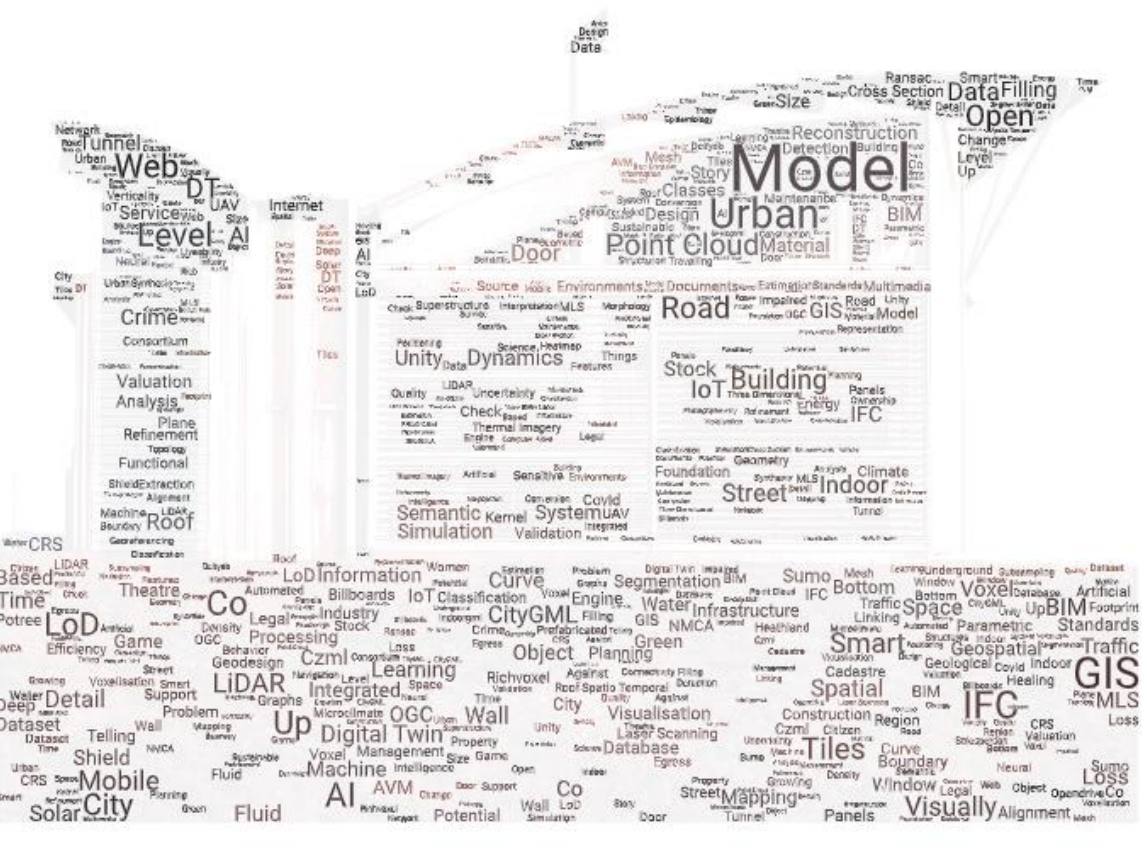
Figure 2: Visualisation of titles in the shape of Magney House, Bingie Point, NSW,